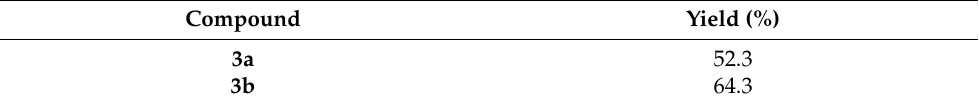
Table 6. Synthetic yields of 3a and 3b